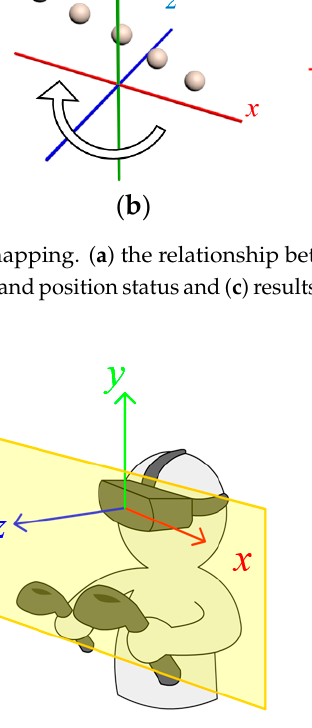
Figure 3. Conceptual image of the virtual screen.